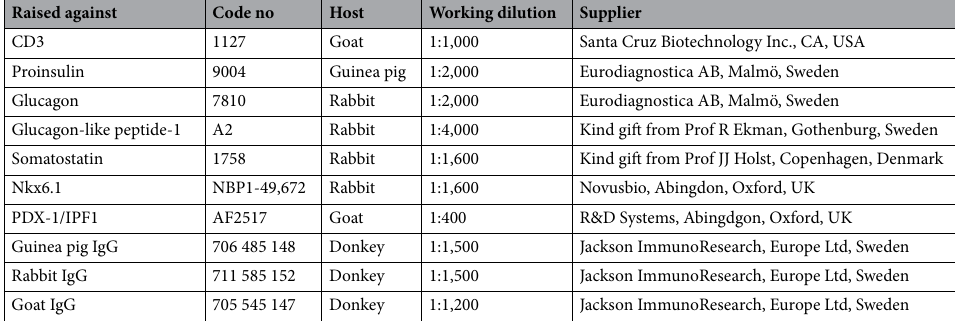
Table 4. Details on primary and secondary antibodies used in immunocytochemistry.